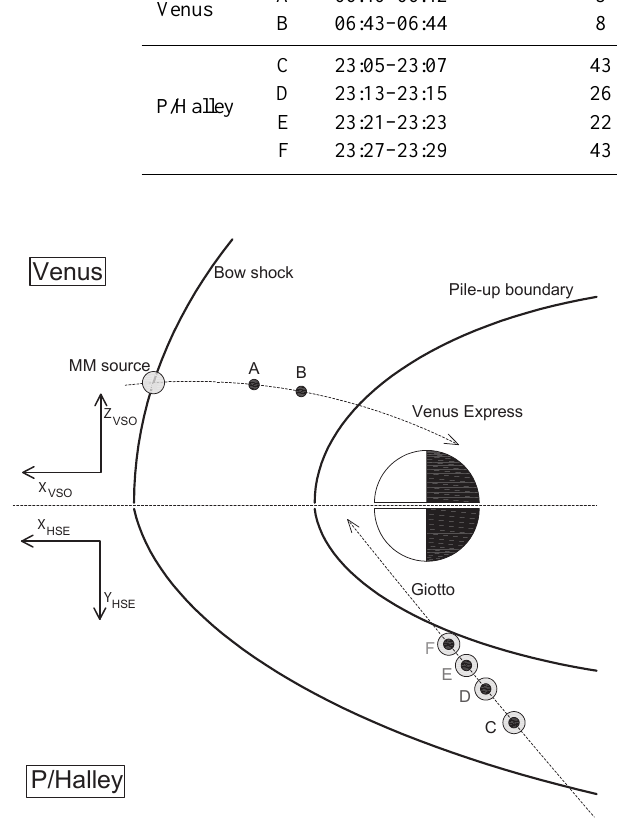
Figure 1. Sketch of the trajectory of Venus Express and Giotto. The position of the observed MM structures are marked by the black dots A–F. The estimated locations of MM generation are marked by the gray shaded